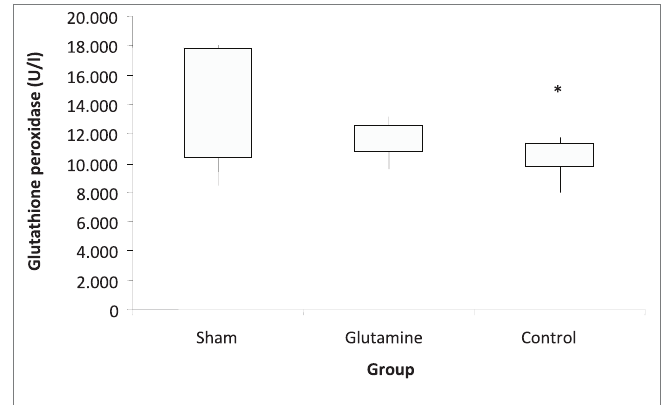
FIGURE 3 - Serum glutathione peroxidase in the three experimental groups. * p <0.05 vs GLN and sham groups.